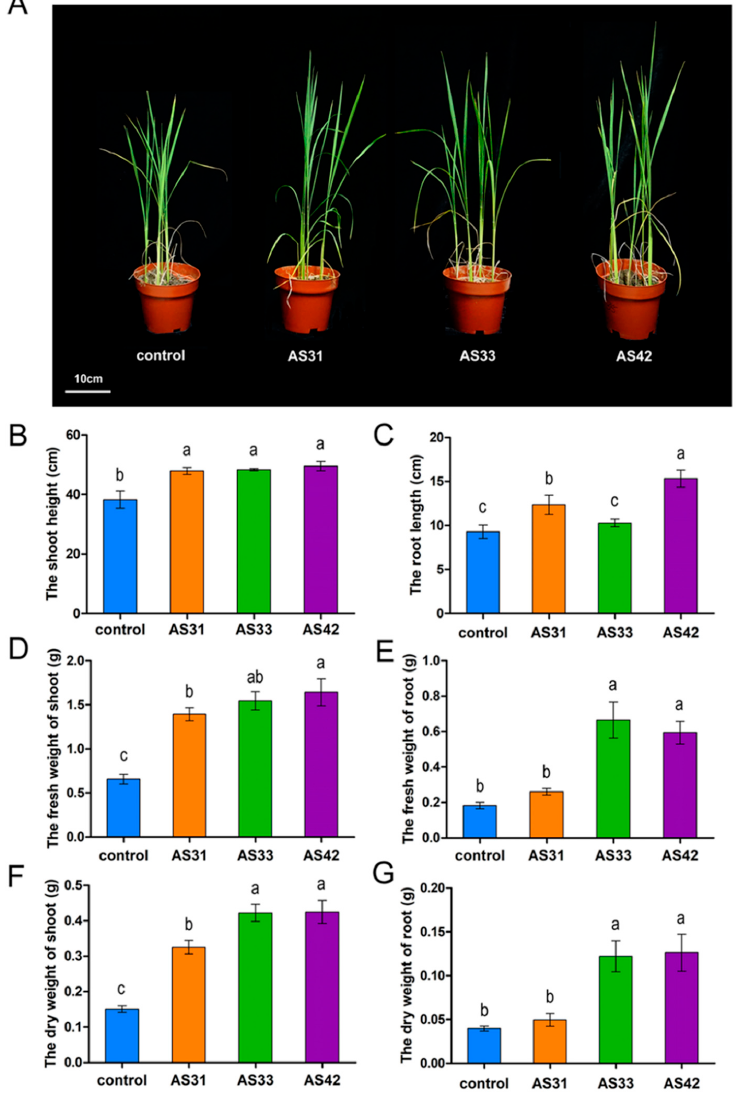
Figure 4. Promotions of rice growth by inoculation of strains AS31, AS33, or AS42 in soils. Differential rice responses to inoculation with strains AS31, AS33, or AS42 in the pot experiments are